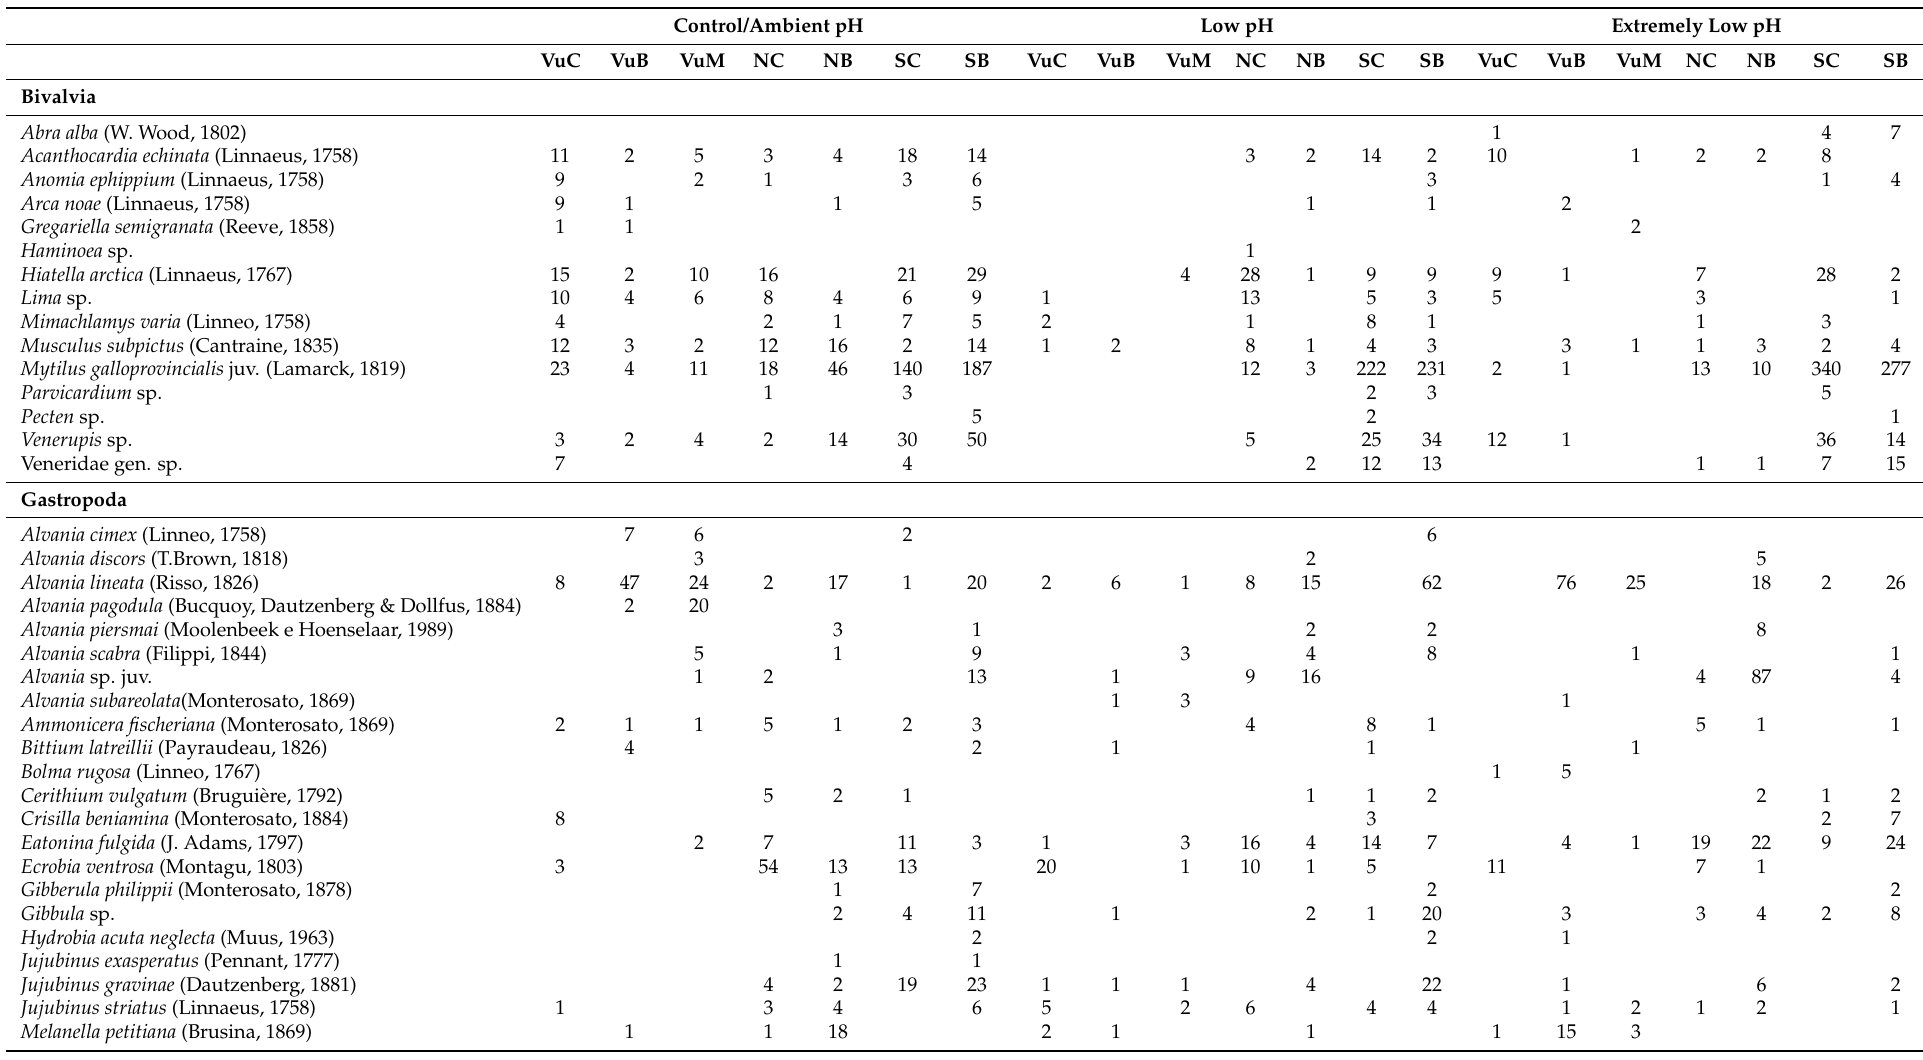
Table 2. Number of individuals divided per species in each site (Vu, N, S), pH gradient (control, low, extremely low) and microhabitat (C = “canopy”, B = “bottom”, M = “dead